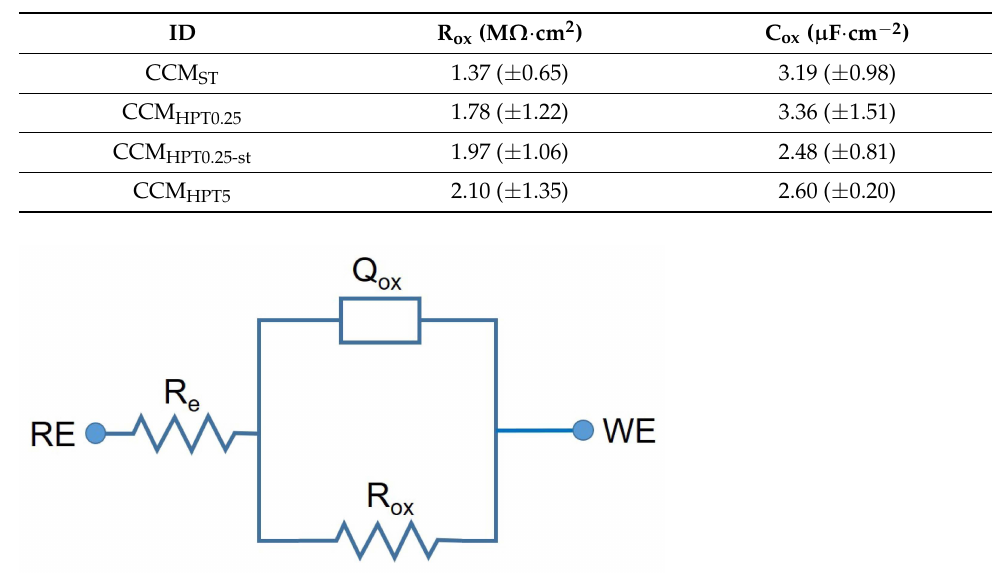
Table 3. Equivalent circuit parameters obtained from EIS data for CoCrMo samples.